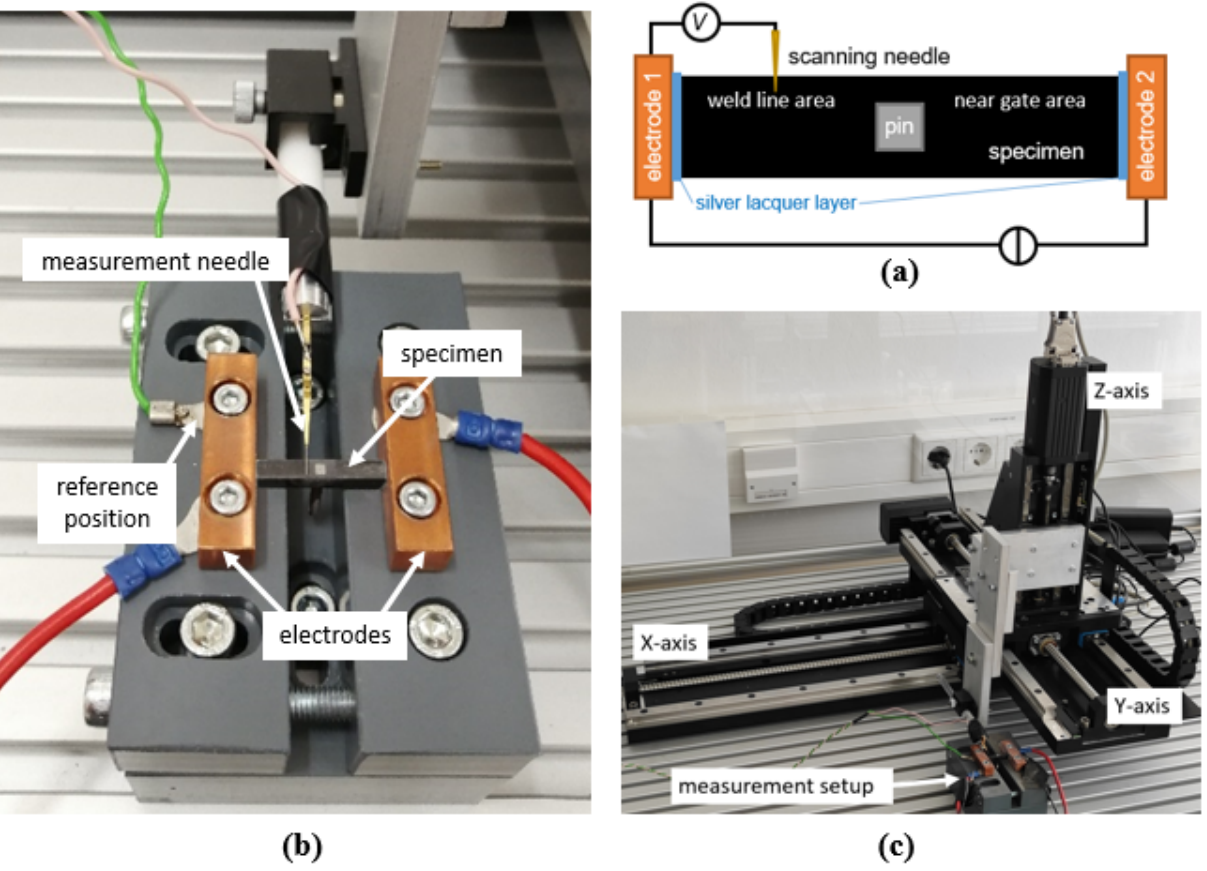
Figure 6. Potential field measurement setup: ( a ) schematic, top view; ( b ) implemented setup; ( c ) whole setup including the combination of cross and linear table used for positioning the scanning needle. Table 5. Positioning accuracies of the X -, Y - and Z -axes. X -Axis Y -Axis Z